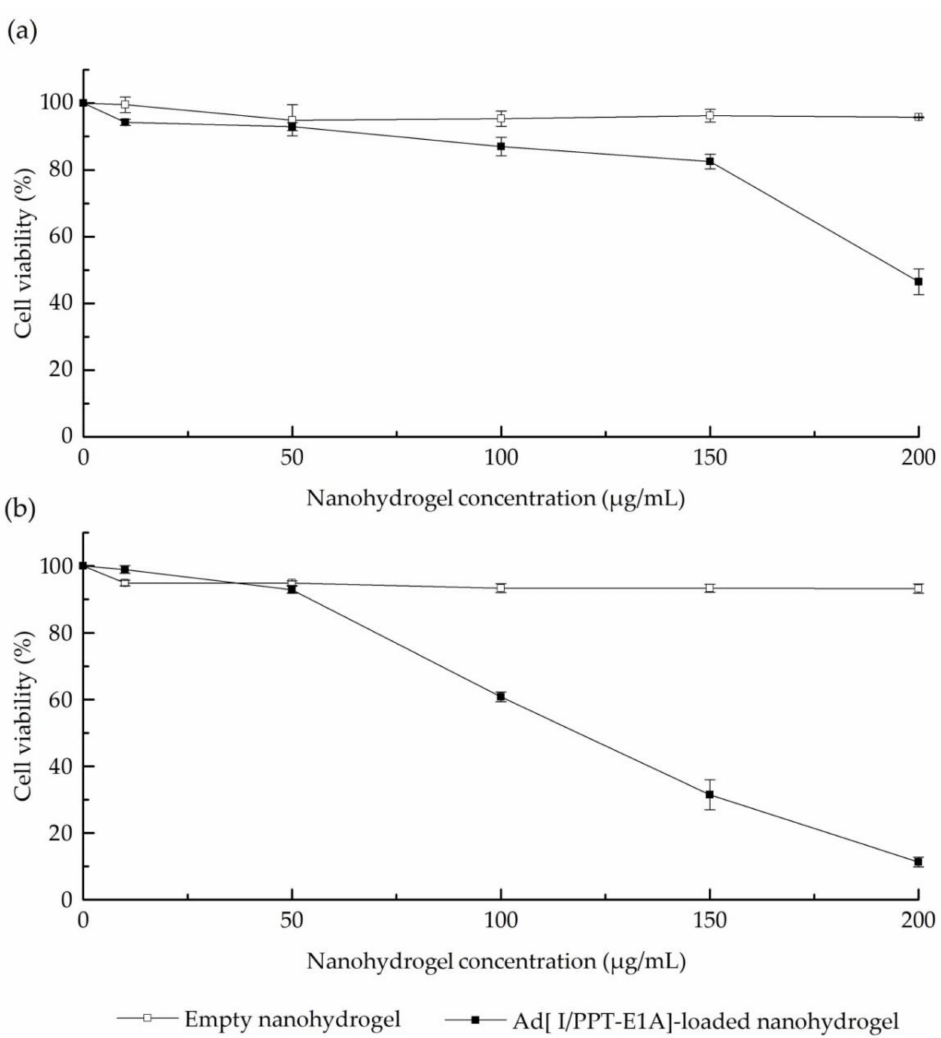
Figure 9. 3-(4,5-dimethyl-2-thiazolyl)-2,5-diphenyl-2 H -tetrazolium bromide (MTT) cytotoxicity assays in LNCaP metastatic prostate cancer cell line of: ( a ) Empty nanohydrogel vs. Ad[I/PPT-E1A]-loaded nanohydrogel after 3 days infection; ( b ) Empty nanohydrogel vs. Ad[I/PPT-E1A]-loaded nanohydrogel after 5 days